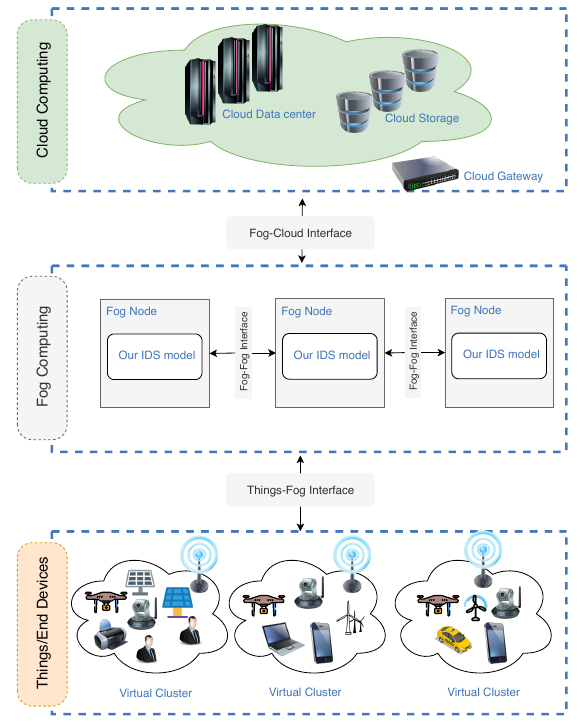
Figure 2. Integration of RDTIDS system in the three-tier fog computing architecture for Internet-of-Things (IoT)